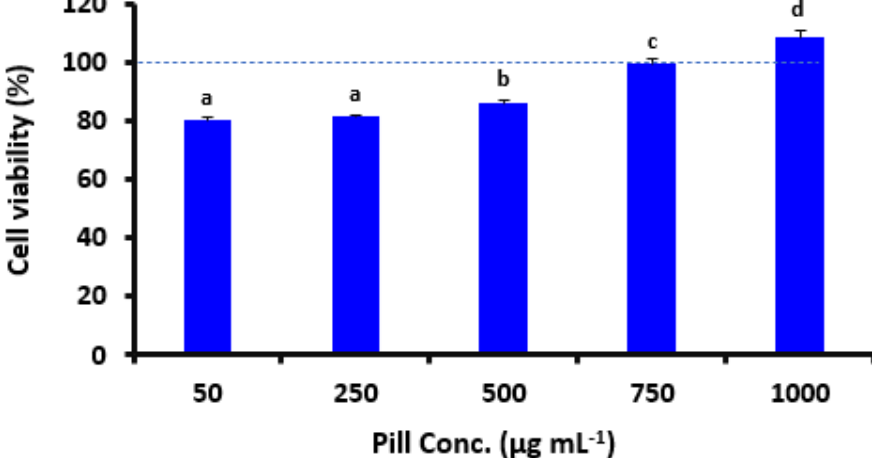
Figure 2. Effect of date seed pills at small and high doses. The polyphenol extracts of pills were